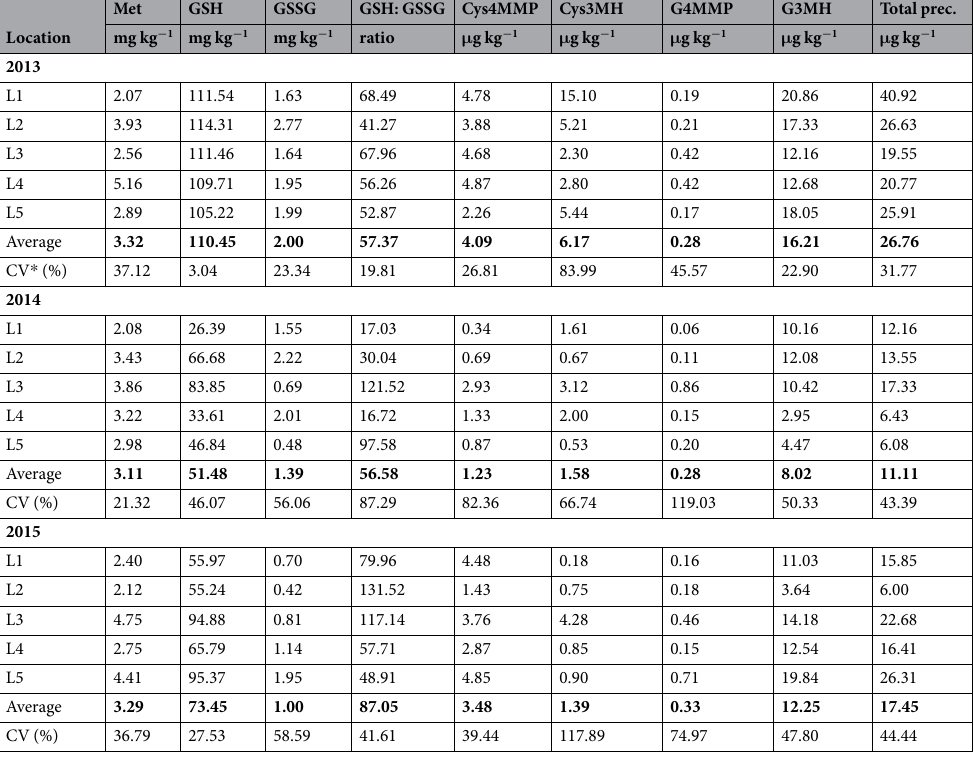
Table 3. L-methionine (Met), glutathione (GSH), oxidized glutathione (GSSG) and thiol precursor content in Sauvignon Blanc grapes from Friuli Venezia Giulia (Italy) in 2013, 2014 and 2015. * Coefficient of